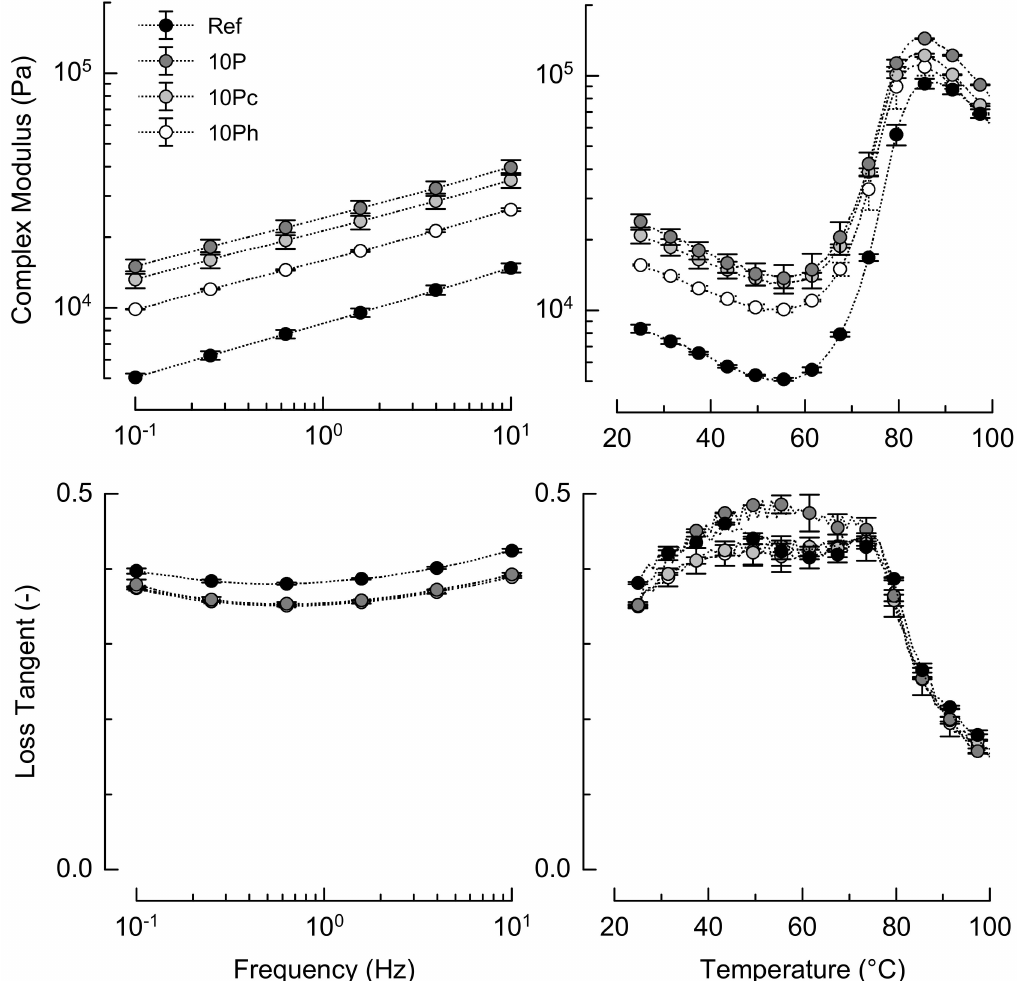
Figure 1. Frequency dependency of dough sti ff ness and the loss tangent at 25 ◦ C (left), and development of sti ff ness and loss tangent during simulated baking (right) ( n = 2). Ref, reference dough; 10P, dough based on 90% wheat flour and 10% pomace; 10Pc, similar to 10P but with pomace soaked in cold water; 10Ph, similar to 10P but with pomace soaked in boiling water. To improve clarity, not all data points are